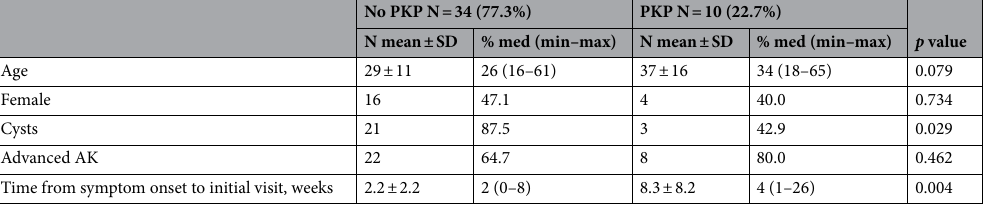
Table 4. Frequency of penetrating keratoplasties. AK Acanthamoeba keratitis, max maximum, med median, min minimum, N absolute number, PKP penetrating keratoplasty, SD standard